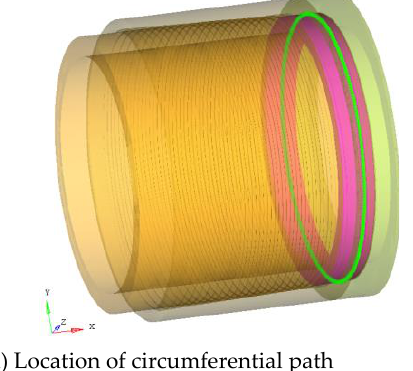
Figure 7. Critical path.